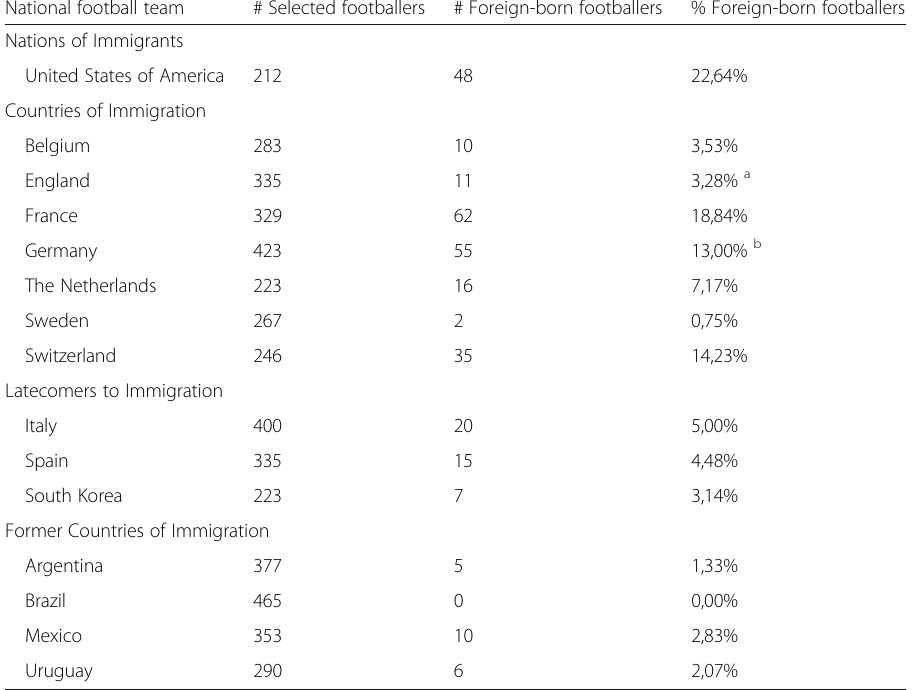
Table 2 Numbers of foreign-born footballers per selected national team at the FIFA World Cup (1930 –